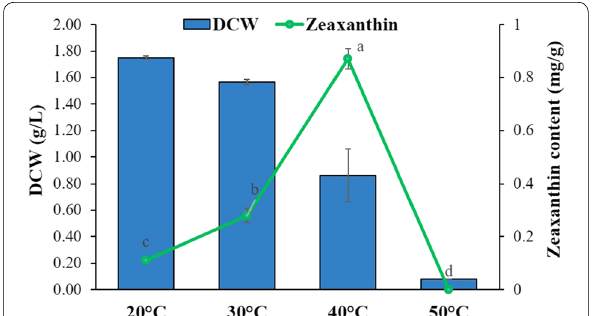
Fig. 7 Effect of various temperature conditions on A. gandavensis MTCC 25325 zeaxanthin accumulation after 72 h of incubation. All statistical significance comparisons between indicated groups were performed using a one-way ANOVA with Fisher’s post-test. Data presented are mean values and their standard deviation